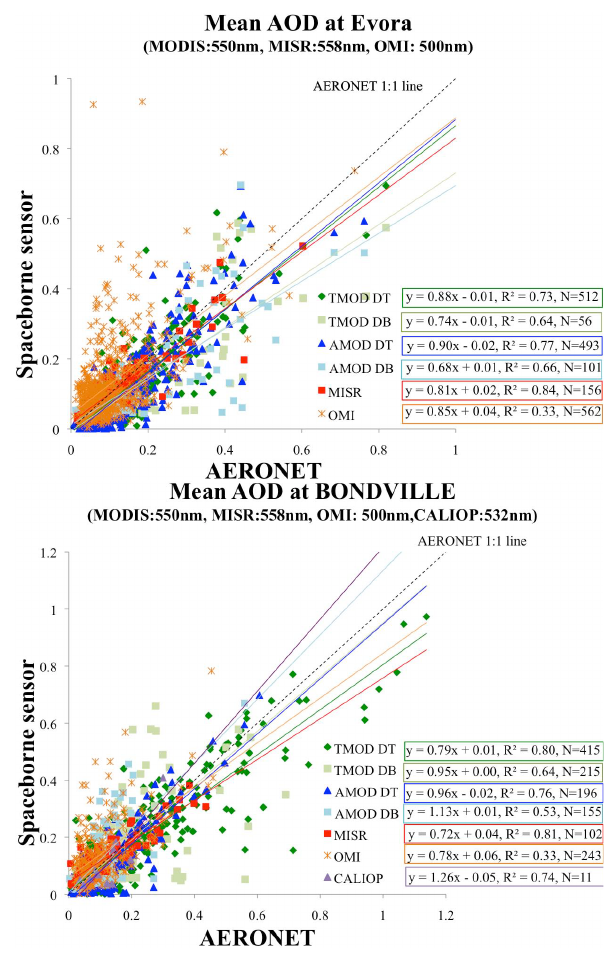
Fig. 8. An example of aerosol analysis using MAPSS: a scatter plot showing the squared correlation coefficient ( R 2 ) between the means of AERONET AOD and AOD retrieved by different spaceborne sensors in 2003–2011 over Evora (Portugal) and Bondville (USA). Data were screened using the following set of QA flags: MODIS QA=3 (Best), MISR QA < =1 (Successful retrieval), OMI QA=0